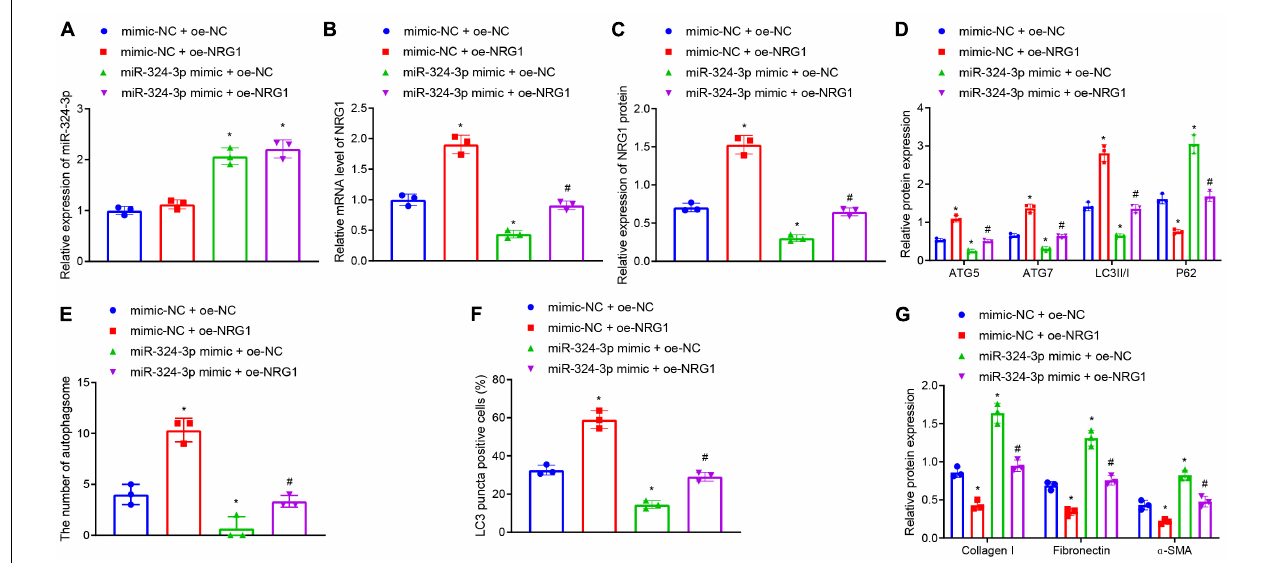
FIGURE 3 | NRG1 overexpression promotes the miR-324-3p-inhibited autophagy to alleviate renal fibrosis. (A) RT-qPCR results of miR-324-3p expression in HK-2 cells with different treatments; (B) RT-qPCR results of NRG1 mRNA expression in HK-2 cells with different treatments; (C) Western blot results of NRG1 protein expression in HK-2 cells with different treatments; (D) level of autophagy-related proteins by Western blot; (E) TEM observation of autophagosomes in HK-2 cells with different treatments; (F) proportion of LC3 positive cells in the HK-2 cells with different treatments by immunofluorescence assay; (G) protein level of fibrosis markers in HK-2 cells with different treatments by Western blot; * p < 0.05 as compared with oe-NC + mimic-NC; # p < 0.05 as compared with miR-324-3p mimic + oe-NC. The measurement data were expressed as mean ± standard deviation. One-way ANOVA was used for data comparisons among multiple groups, followed by Tukey’s post hoc test. The cell experiments were repeated three times